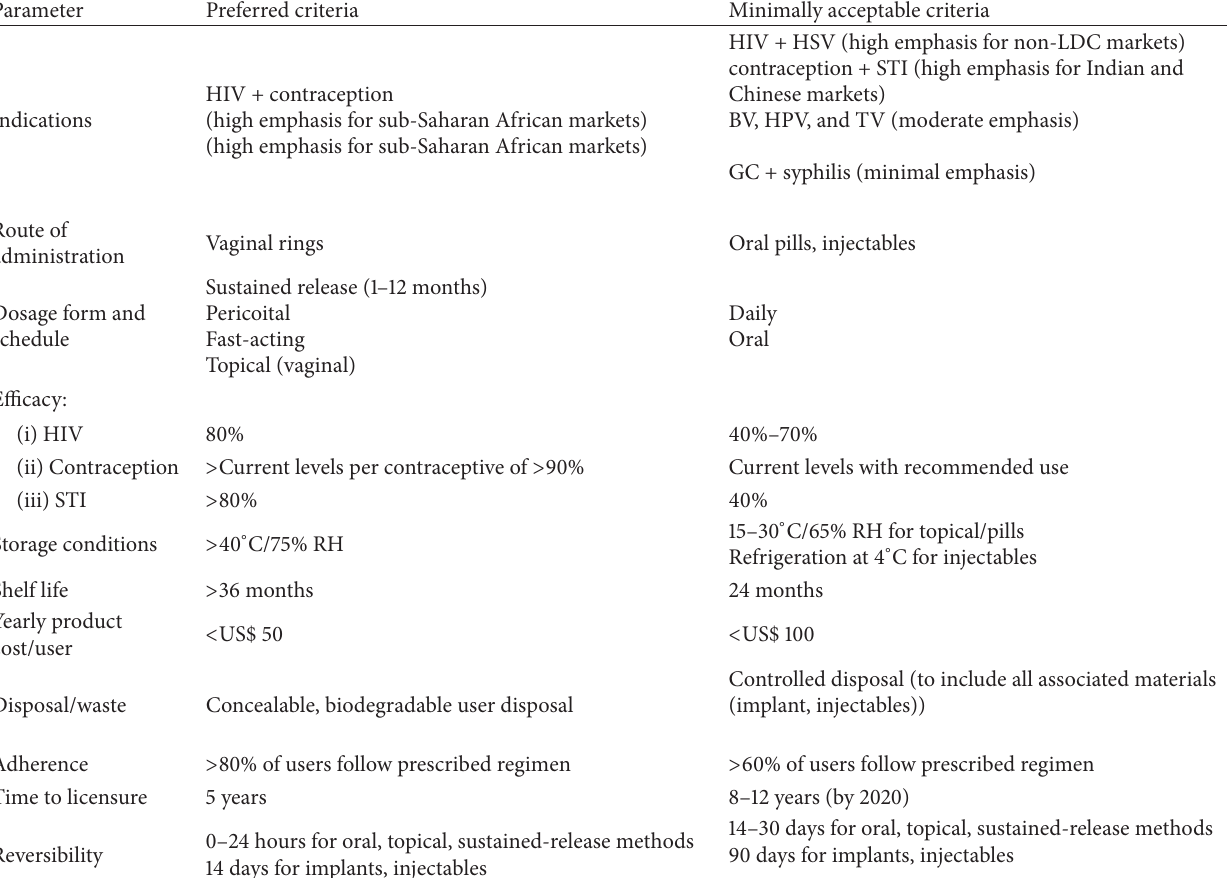
Table 2: TPP parameters for prioritizing MPT